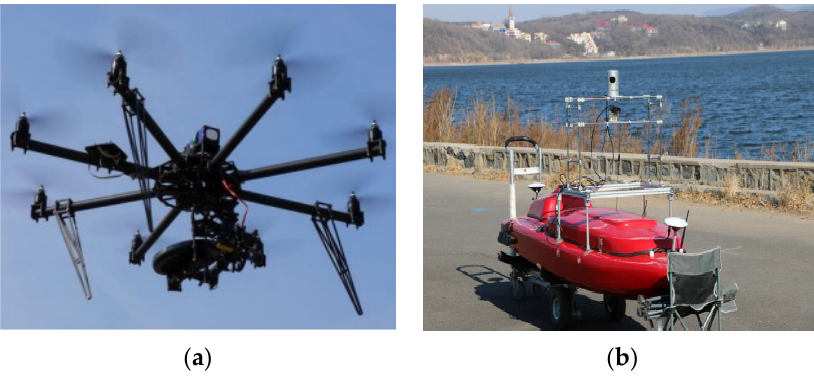
Figure 3. Experiment Vehicles: ( a ) a UAV is equipped with a Velodyne VLP-16 LiDAR to generate the Model point cloud, where the resolution level is 1 m; ( b ) a USV is equipped with a Velodyne 32e Lidar, which could generate the local Scan point cloud at the resolution level at 0.2 m.